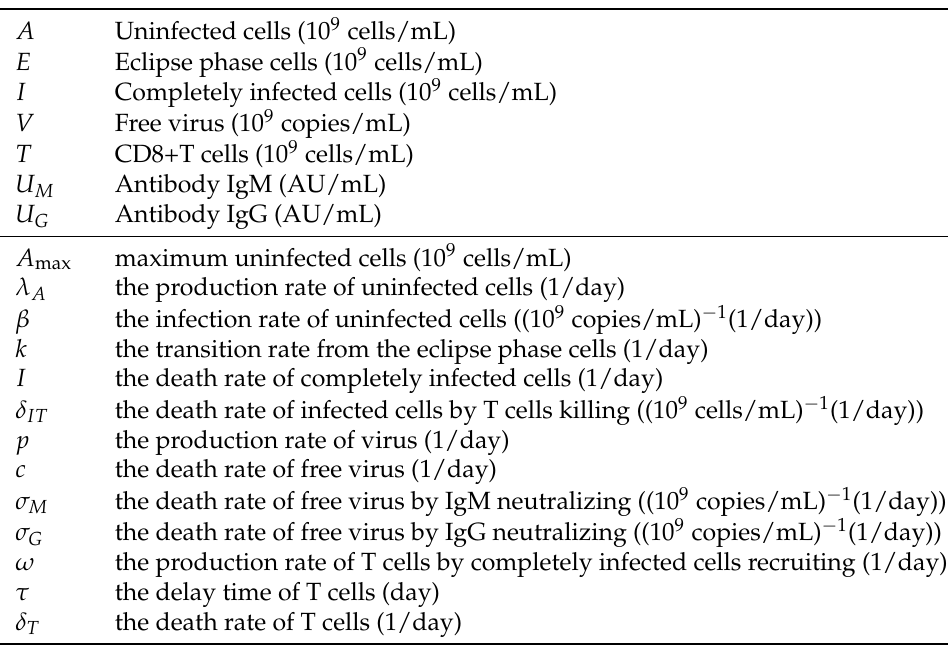
Table 1. The variables and the parameters in the Model 1 and Model